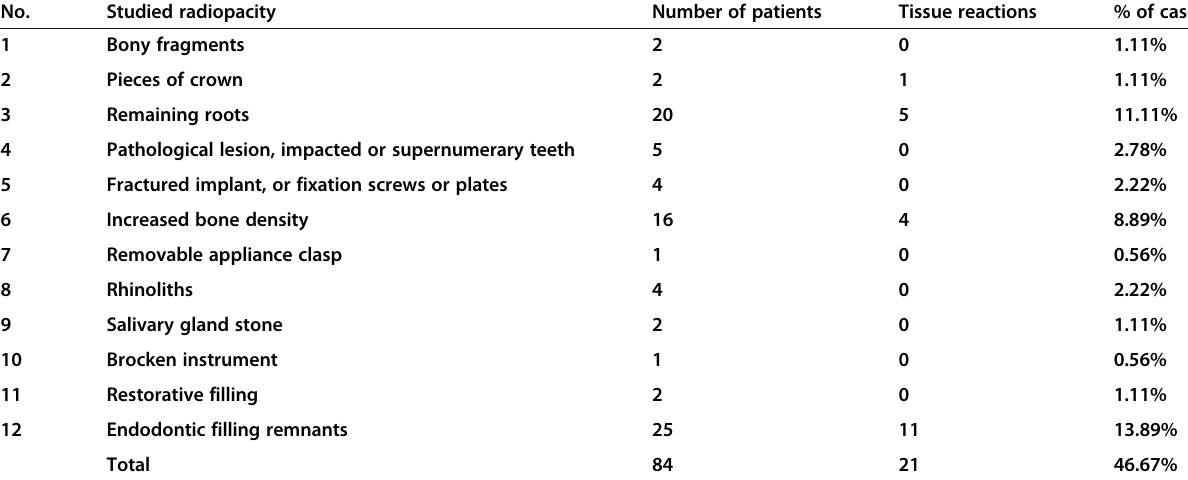
Table 1 Distribution of radiopacities along the studied 180 CBCT scans No. Studied radiopacity Number of patients Tissue reactions % of